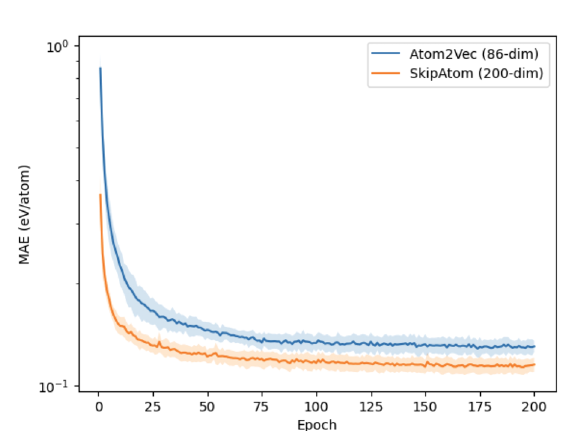
Fig. 3 Atom2Vec versus SkipAtom validation error during training. Mean absolute error during training for the Elpasolite Formation Energy prediction task, for the Atom2Vec and SkipAtom representations. The average MAE over ten folds is